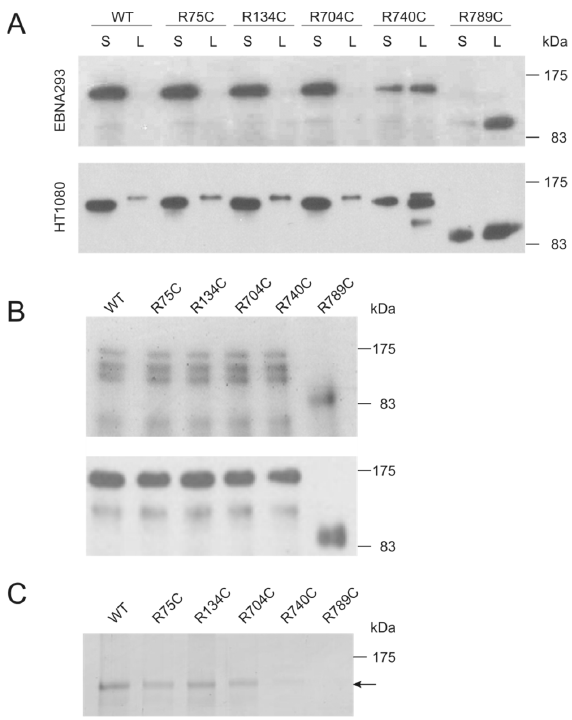
Figure 1. Recombinant expression of collagen II variants. ( A ) 293 Epstein–Barr nuclear antigen (EBNA) (upper panel) and HT1080 cells (lower panel) were transfected with collagen II constructs (WT, R75C, R134C, R704C, R740C and R789C) and the expression and secretion was analyzed using immunoblots. Supernatants (S) and cell lysates (L) were harvested three days post-transfection and separated by SDS PAGE (8% gel) under reducing conditions. Collagen II was detected with an antibody directed against the myc epitope. ( B ) Coomassie blue stained SDS-PAGE gel and immunoblot of purified collagen II variants using an antibody directed against collagen II (upper panel) and the myc epitope (lower panel). ( C ) Collagen II variants were treated with trypsin at 25 °C for 2 min followed by SDS-PAGE. The collagens were visualized by silver staining. WT, as well as R75C, R134C and R704C collagens were resistant to trypsin and displayed a single band of the size of the triple helical domain without the N- and C-propeptides (indicated by an arrow), whereas R740C and R789C collagens were completely degraded.